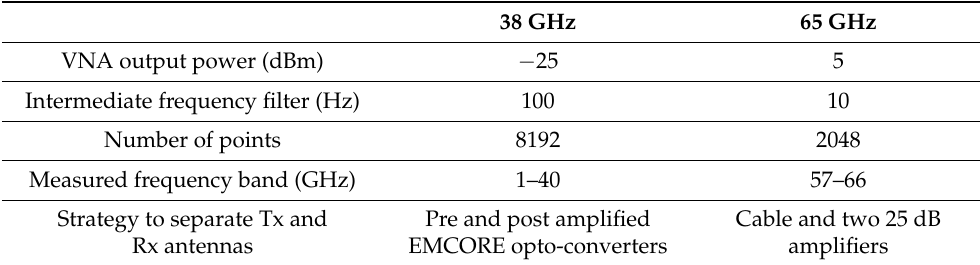
Figure 2. Measurement setup: ( a ) 38 GHz and ( b ) 65 GHz. Electrical parameters to configure the VNA are shown in Table 3. For both bands, the system was through (THRU) calibrated to eliminate the effect of cables and amplifiers or the RoF, thus, the VNA measured the radio channel between antennas. Table 3. Parameters for channel sounding for each band.